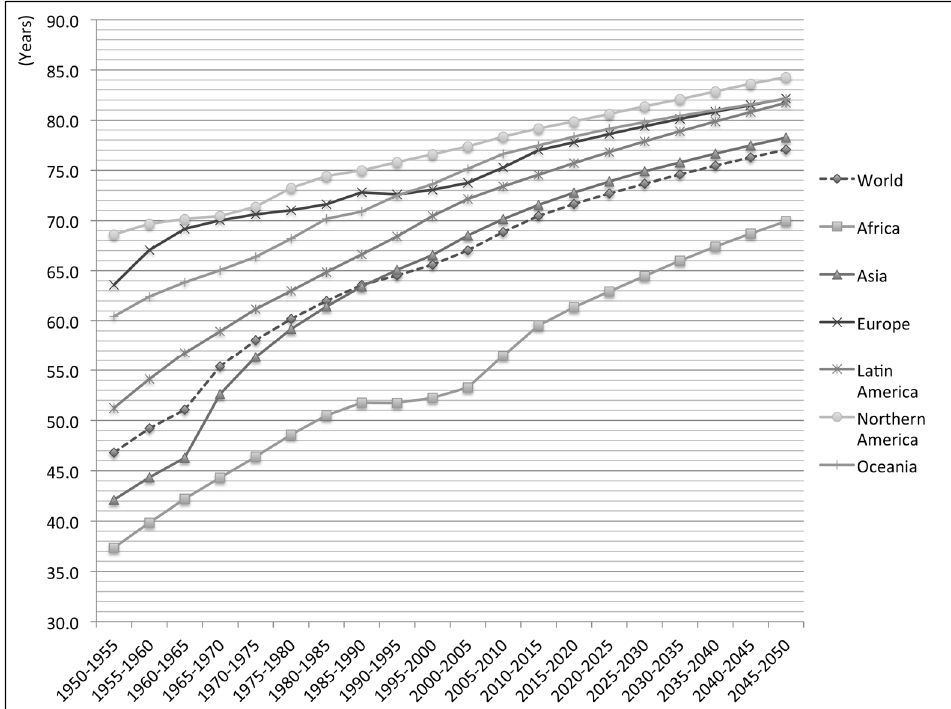
Figure 4. Trends in life expectancy at birth in the world and six regions. Note: Created from life expectation estimations at birth from 1950–2010 and projections with medium fertility variant for 2015–2050 by the United